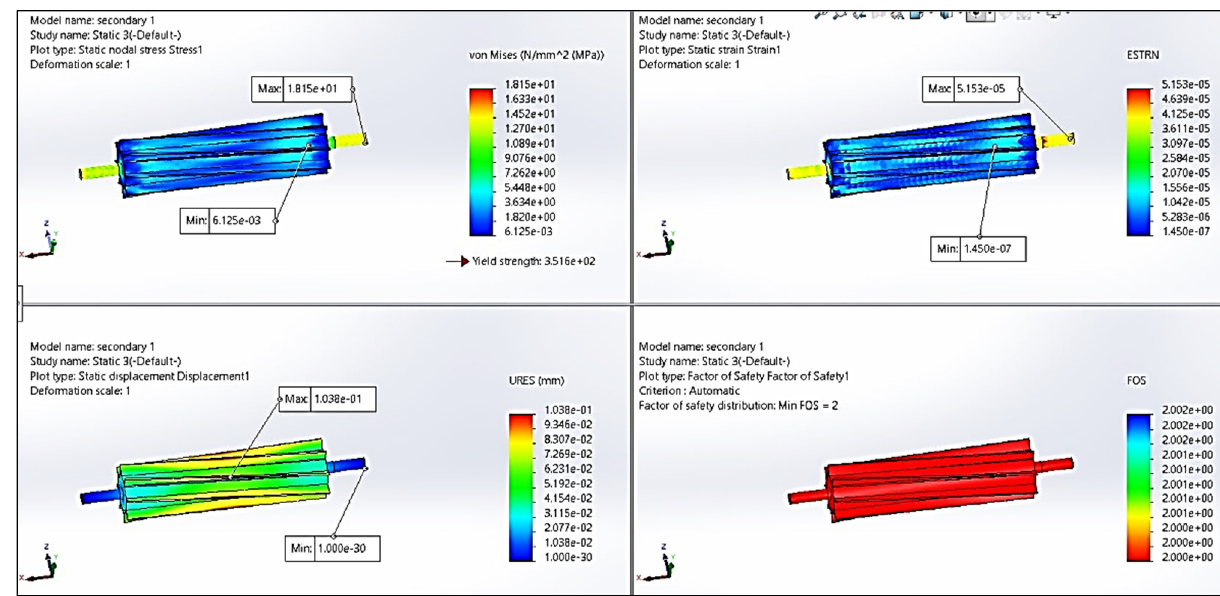
Figure 14. Stress, strain, displacement, and factor of safety of secondary extraction roller with a 200 N force considered .